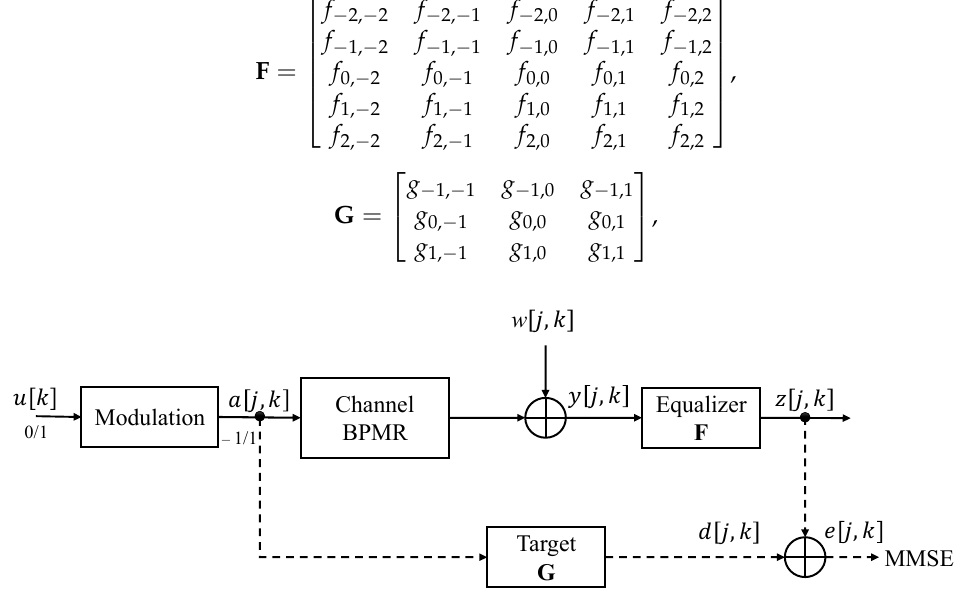
Figure 2. Training model for estimating the GPR target and equalizer parameters.